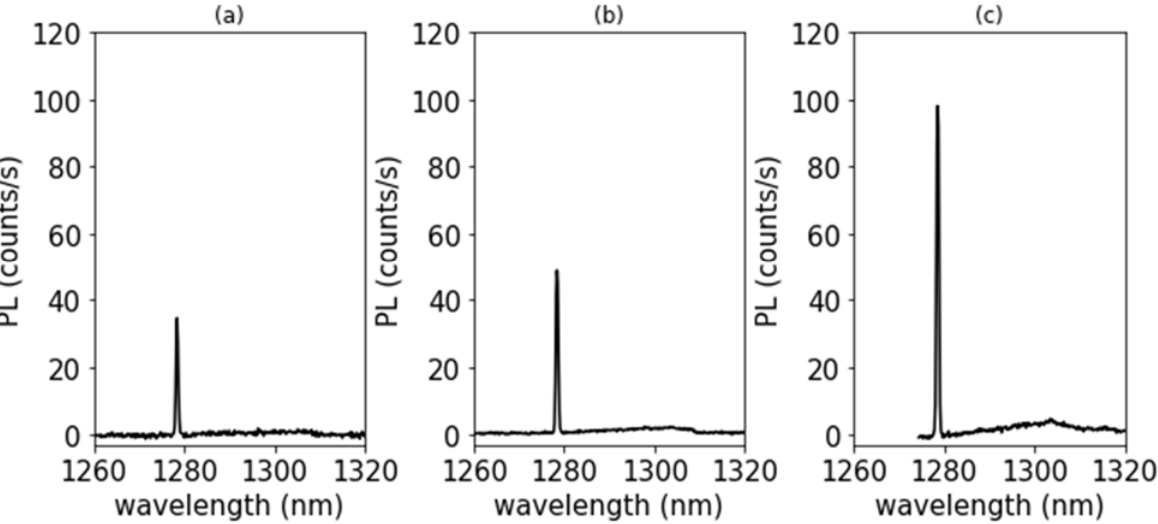
Figure 4. Near-IR photo-luminescent spectra collected at a sample temperature of 3 K from Si (111) samples that had received ( a ) one and ( b ) ten proton pulses at a flux of 6.9 (+/ − 0.7) × 10 9 protons/cm 2 /pulse, and ( c ) one pulse at a flux of 7.9 (+/ − 1.6) × 10 10 protons/cm 2 /pulse. The relative intensities are normalized to the signal integration time for comparison.